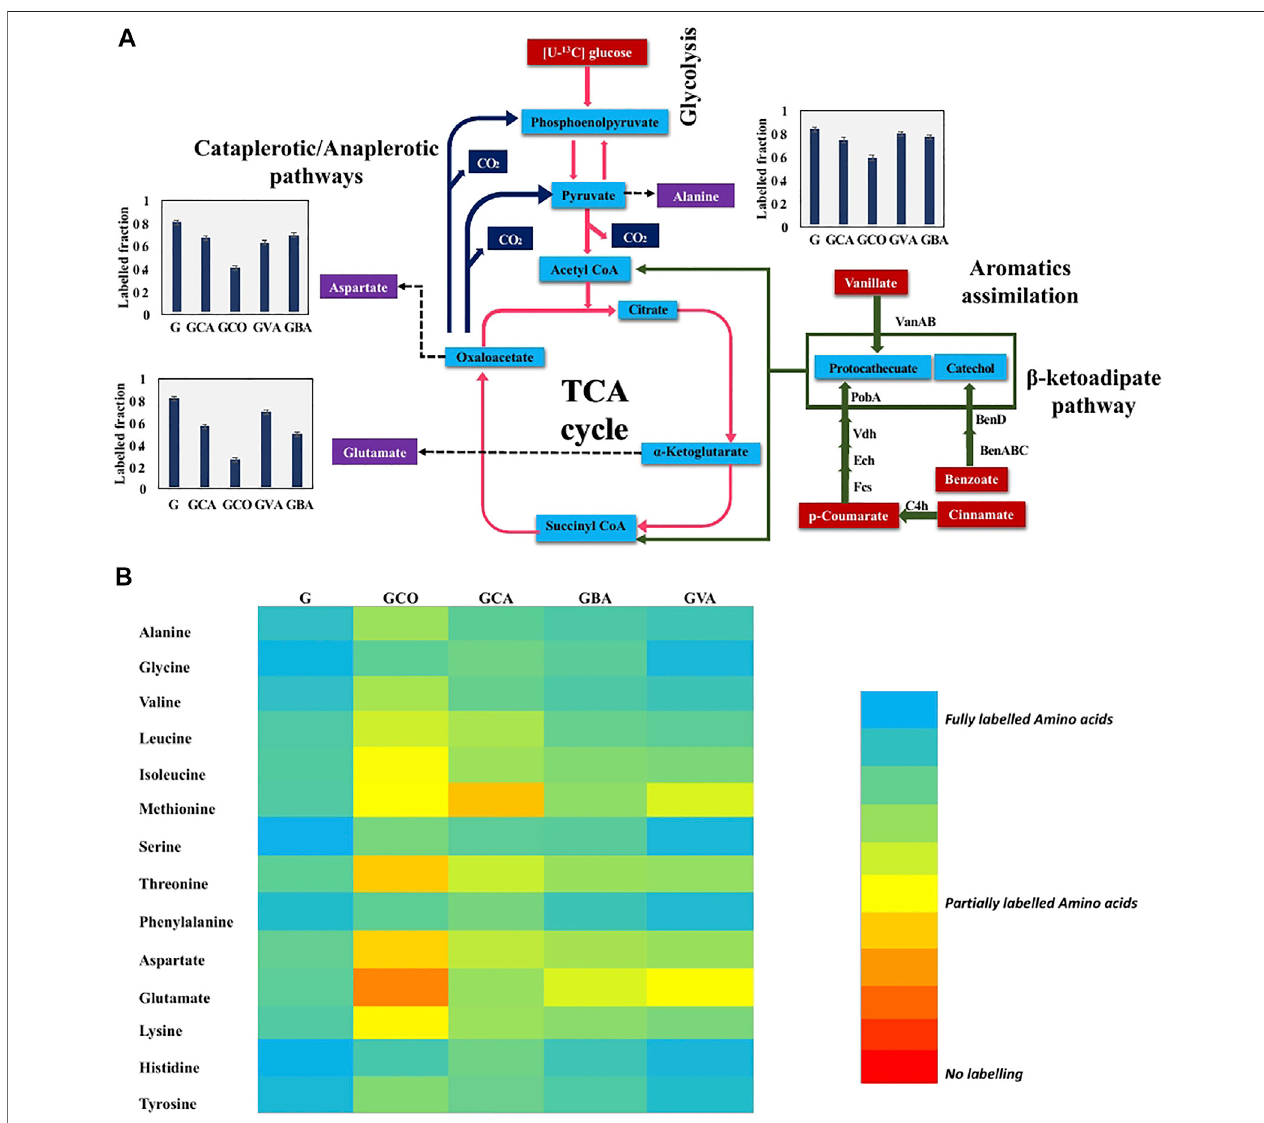
FIGURE 5 | 13 C- fi ngerprinting study for tracing aromatic assimilation. Fully labeled [U- 13 C] Glucose (5 g/L) in BTM 2 medium was used in culturing C. glutamicum strain along with 20 mM concentration of aromatics to study aromatic preference in C. glutamicum strain. (A) Lignin derived aromatics (p-coumaric acid, cinnamic acid, vanillicacid,andbenzoicacid)assimilationdeterminationbytracingreductioninlabeledfractioninkeyaminoacids(alanine,glutamicacid,andasparticacid).Cinnamate to p-coumarate catalyzed by C4h (cinnamate 4-hydroxylase), p-coumarate to protocathecuate catalyzed by Fcs (feruloyl-CoA synthetase), Ech (Enoyl-CoA hydratase),Vdh (vanillindehydrogenase),and PobA(p-hydroxybenzoatehydroxylase),vanillatetoprotocathecuatecatalyzedbyVanAB(vanillatemonooxygenase),and benzoate to catechol catalyzed by BenABC (benzoate 1,2-dioxygenase), BenD (1,6-dihydroxycyclohexa-2,4-diene-1-carboxylate dehydrogenase). Labeled fraction in aspartate, alanine, and glutamate is shown in charts where G: [U- 13 C] Glucose (5 g/L) in BTM 2 medium batch; GCA: [U- 13 C] Glucose (5 g/L) + 20 mM cinnamic acid